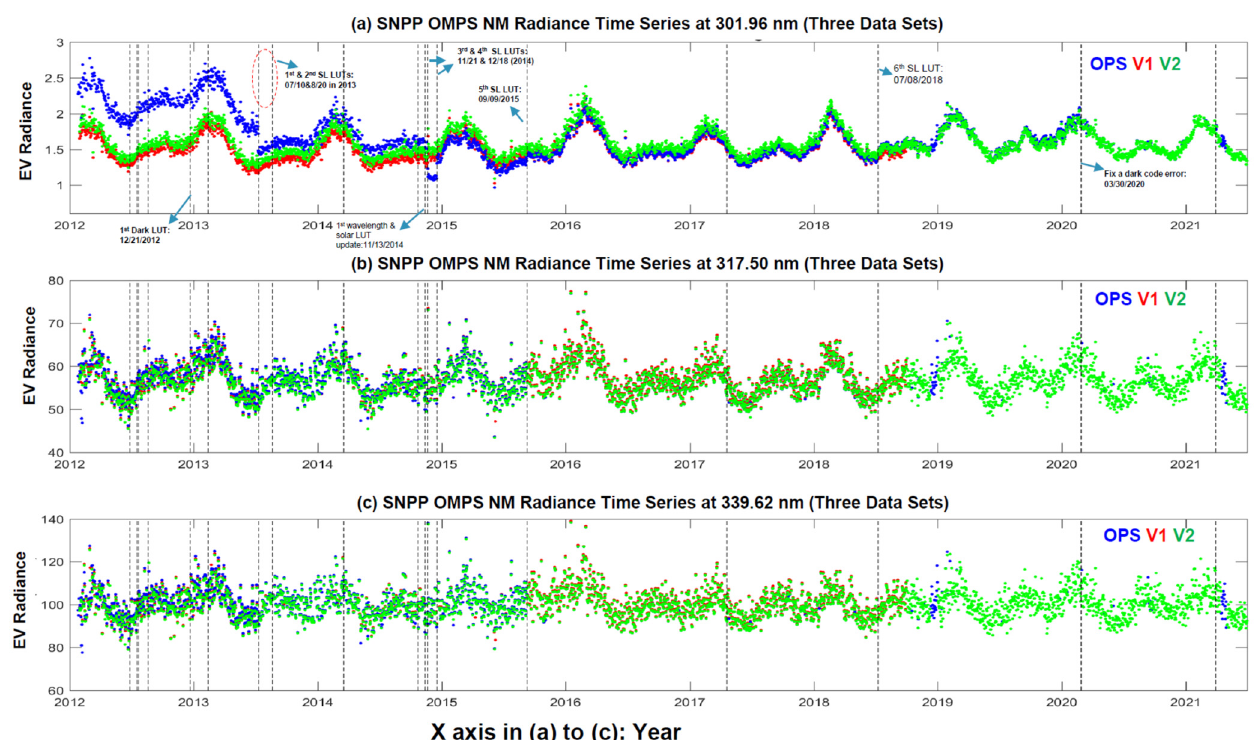
Figure 9. Time series of long-term SNPP OMPS NM averaged radiance at three wavelengths (301.96 nm, 317.497 nm, and 339.622 nm) over the tropic areas (20°N~20°S) among the three data sets. Here, the three data sets consist of operational (OPS) (blue color), the 𝑣 1 reprocessed (red color), and 𝑣 2 reprocessed (green color). The data cover the period from 30 January 2012 through to 30 June 2021, except for the 𝑣 1 data set that covers the period until 30 September 2018; a series of straight dash lines in the figure represent the implementation date with respect to a specific calibration table. In ( a ), the updates of seven types of the LUTs are highlighted: 1st dark LUT in December 2012, 1st and 2nd SL LUTs in middle 2013, the first SOL and wavelength calibration LUTs in November 2014, 3rd and 4th SL LUTs in late 2014, 5th SL LUT in September 2015, 6th SL LUT in July 2018, and the dark code shifting error correction in March 2020, referring to Appendix A; ( a ) 301.96 nm, ( b ) 317.497 nm, ( c ) 339.622